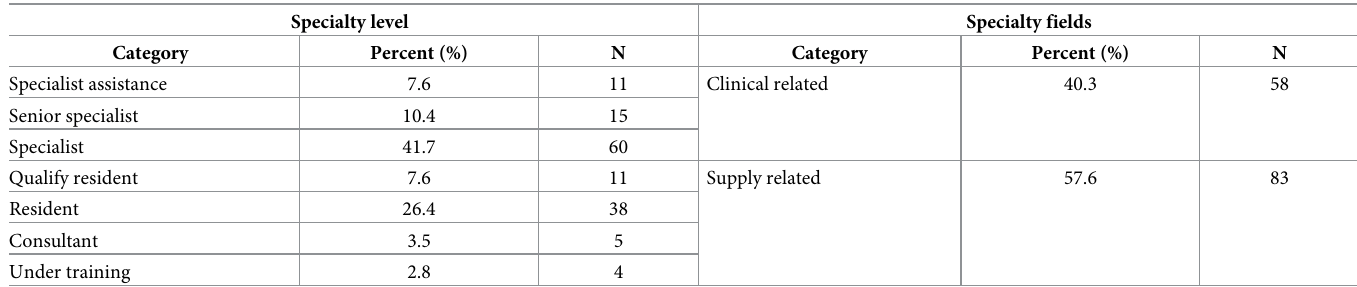
Table 2. Distribution of RMS pharmacists based on their specialty fields and specialty levels.